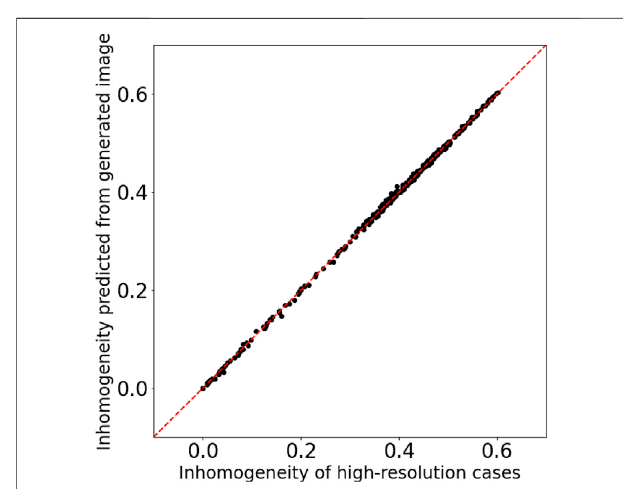
FIGURE 8 | Comparison of the inhomogeneity calculated from the density values on the grids and the inhomogeneity predicted from the distribution maps. The coef fi cient of determination ( R 2 ) is equal to 0.999.